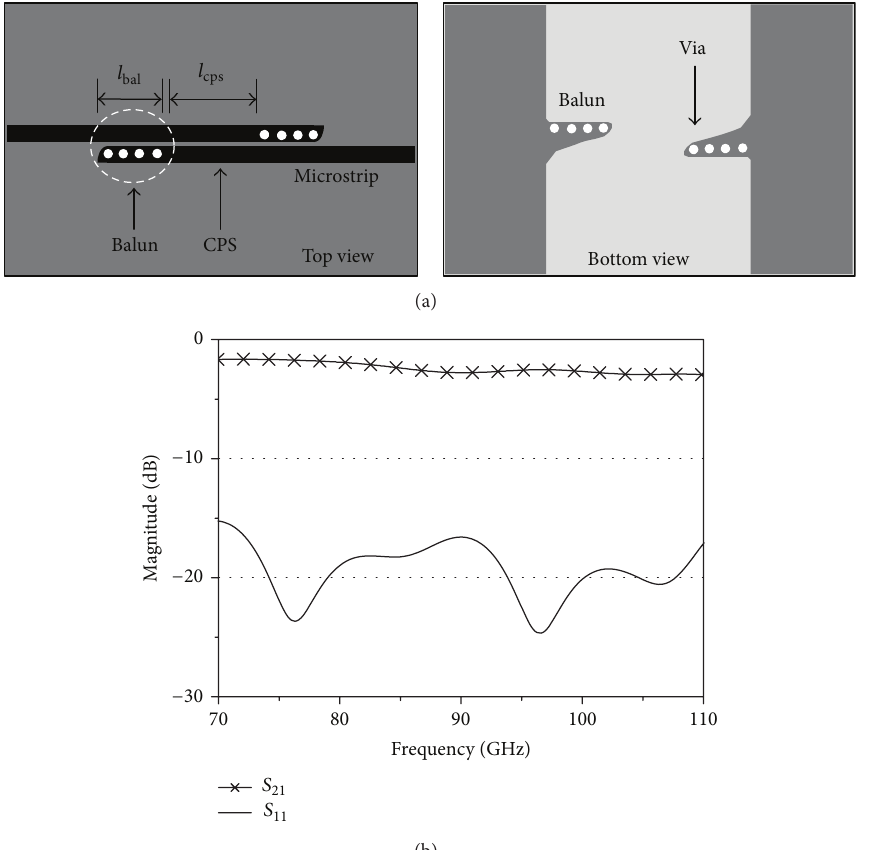
= 3.3 and 𝑙 = 2.29 (via diameter bal cps